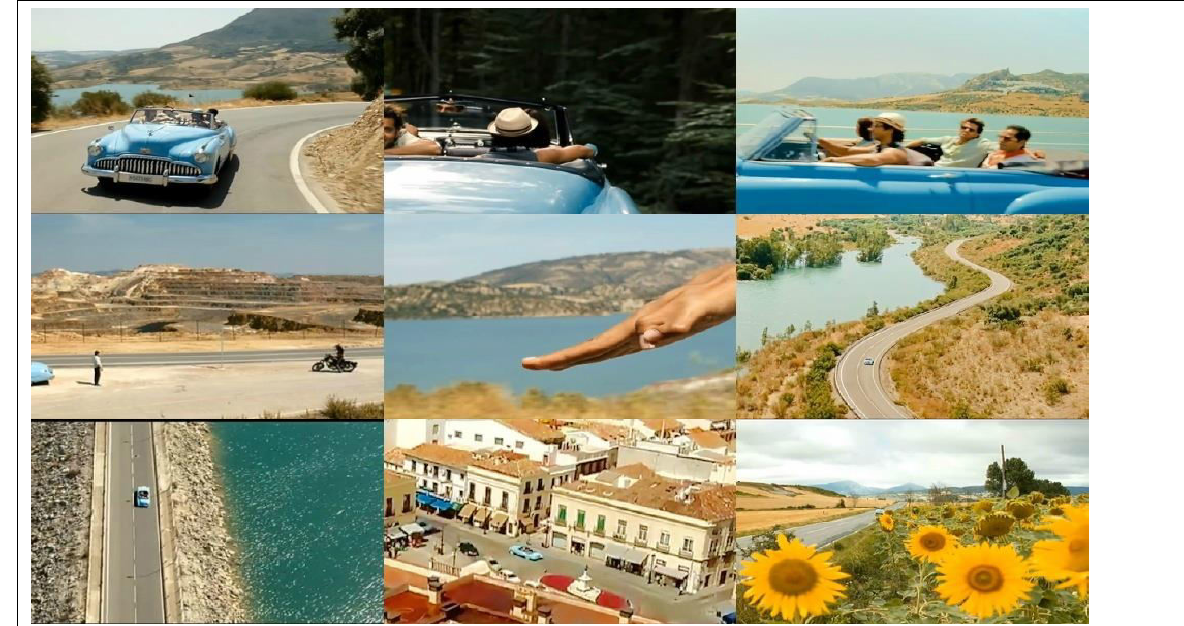
Picture 4: Screen grabs from a song from Zindagi Na Milegi Doobara (YouWon’t Get another Life), a 2011 Bollywood comedy drama set against the scenic backdrops of the Spanish landscape. It won many awards for direction and choreography and, inspite of some critical reviews, was a ‘runaway hit’ and earned approximately US $28 million worldwide. (Source: Hindustan Times, Eros,